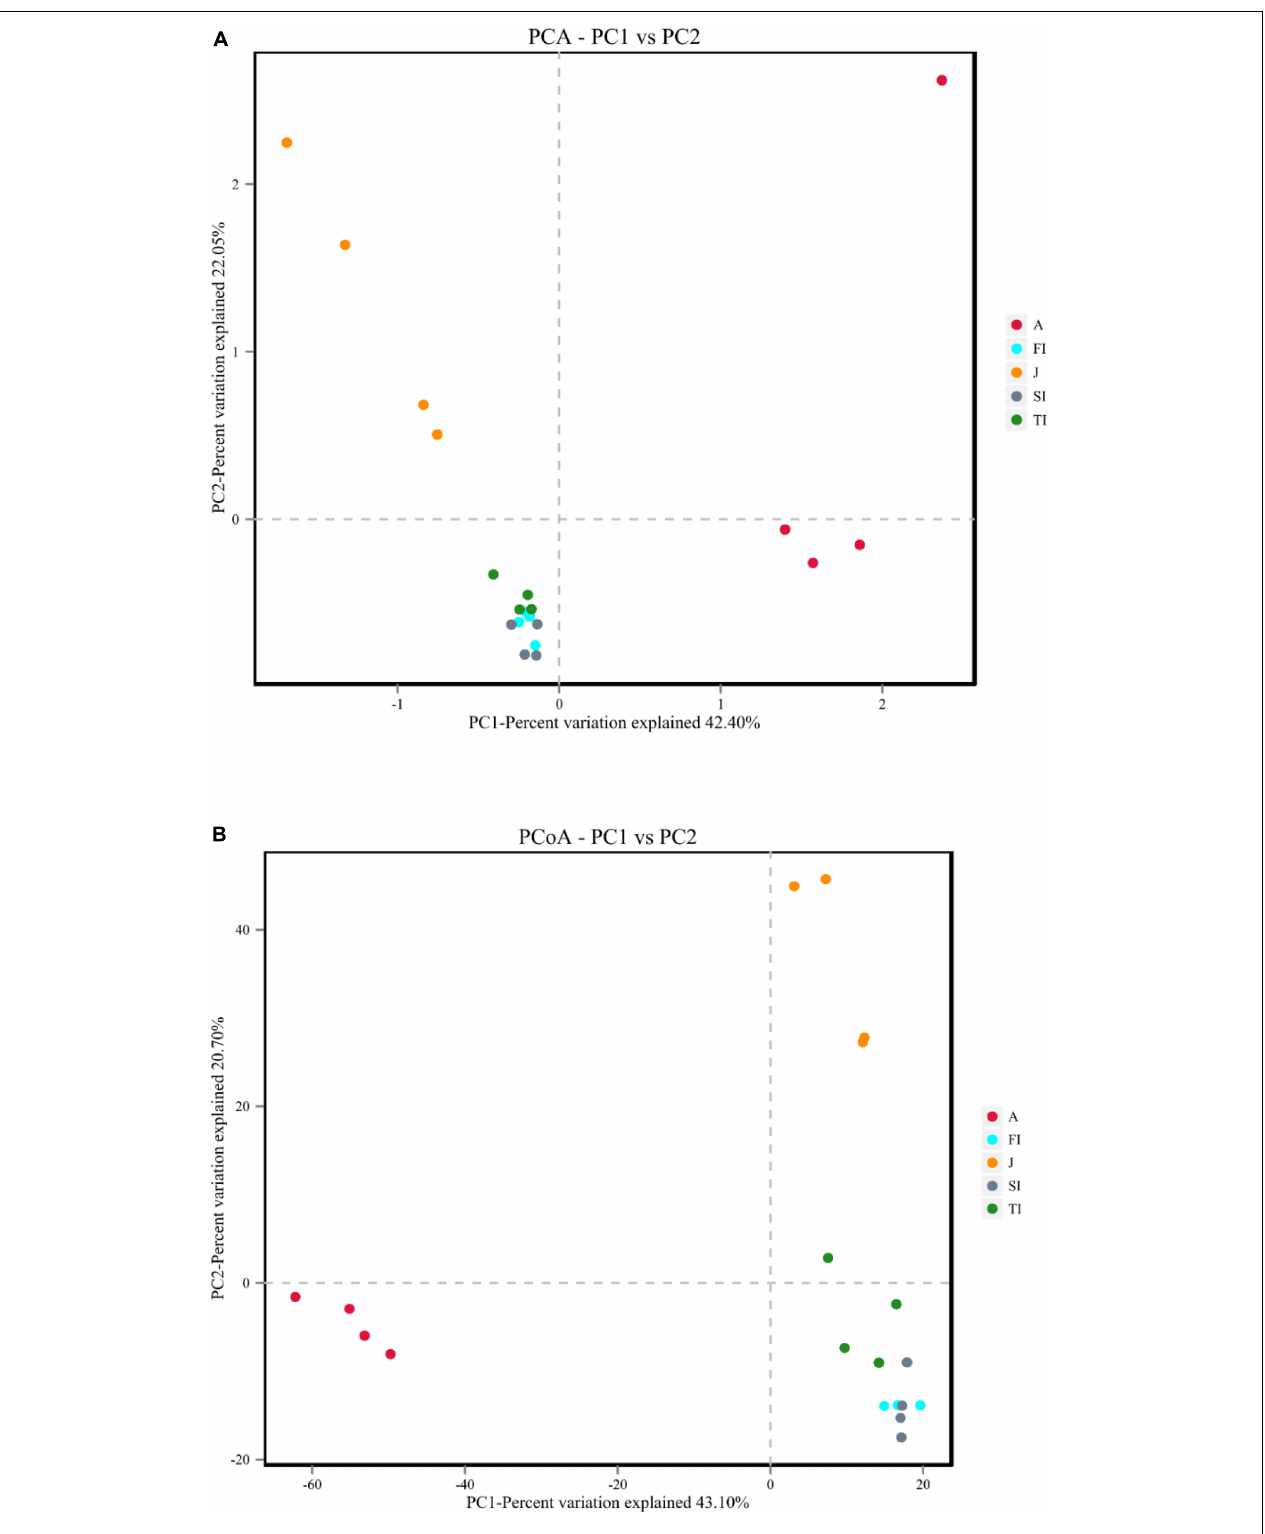
FIGURE 5 | (A) Principal component analysis plot of intestinal microbiota at different development stages. (B) Principal coordinate analysis plots of Bray–Curtis comparing the intestinal microbiota at different development stages.